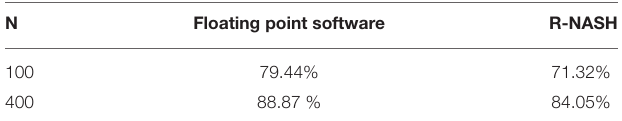
TABLE 3 | Accuracy result of STDP learning for SNNs.